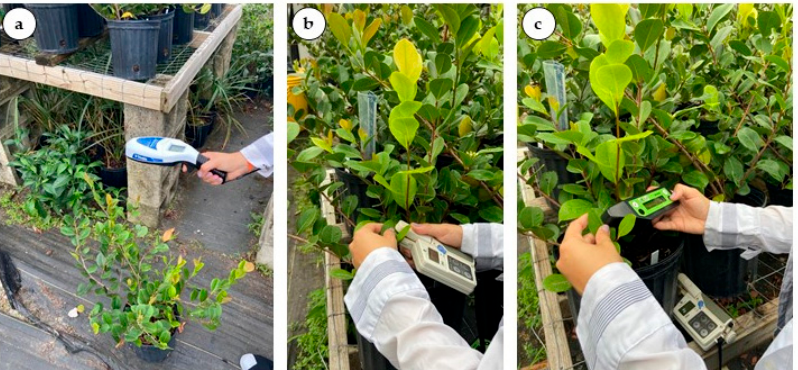
Figure 5. Sensors parameters readings. ( a ) Normalized Difference Vegetation Index (NDVI) by GreenSeeker TM . ( b ) Relative chlorophyll content by SPAD. ( c ) Relative chlorophyll content by atLEAF.